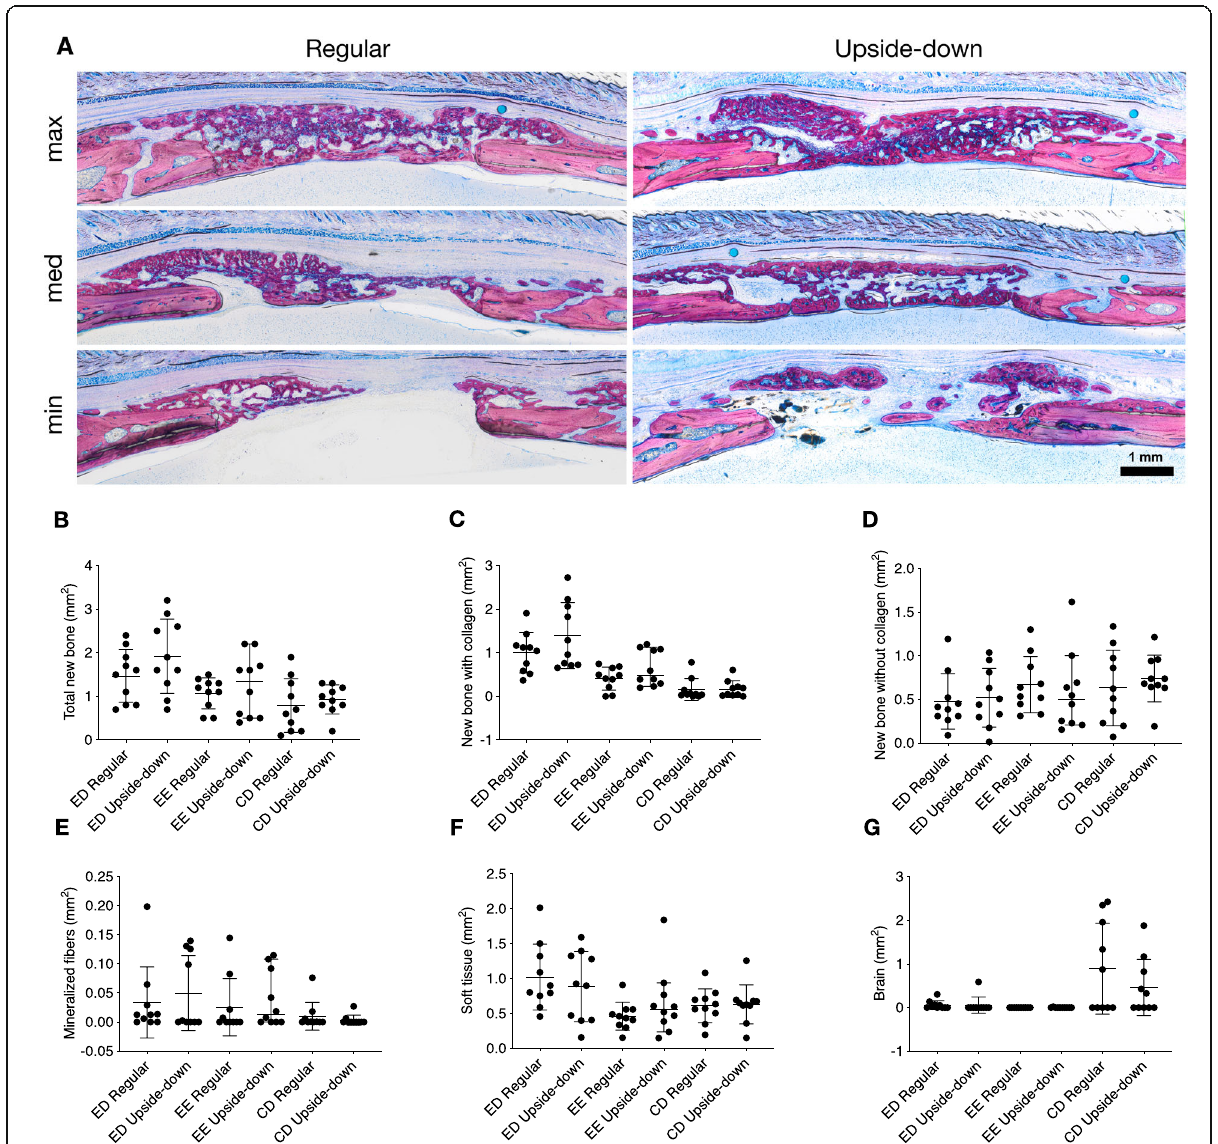
Fig. 6 Histological and histomorphometric results. a Histological overview of the defect anatomy after 4 weeks of healing. Quantitative histomorphometric analysis of b total new bone, c new bone with collagen, d new bone without collagen, e mineralized fibers, f soft tissue, and g brain prolapse in all groups and regions of interest (bars and whiskers represent medians and interquartile ranges). CD, central defect area; ED, ectocranial defect area; EE, ectocranial defect